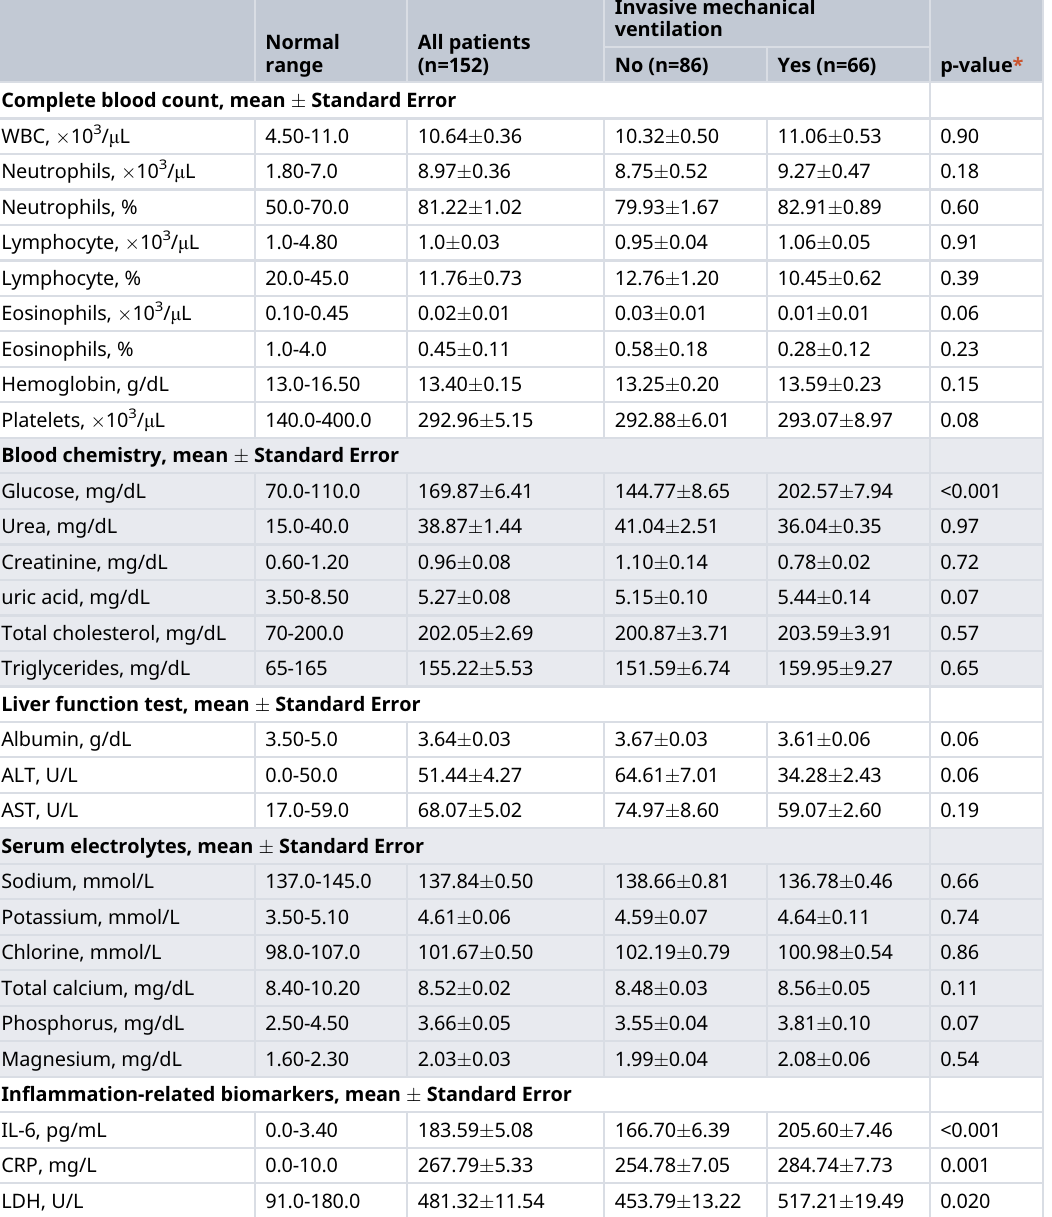
Table 2. Laboratory parameters of ICU-admitted patients infected with SARS-CoV-2.